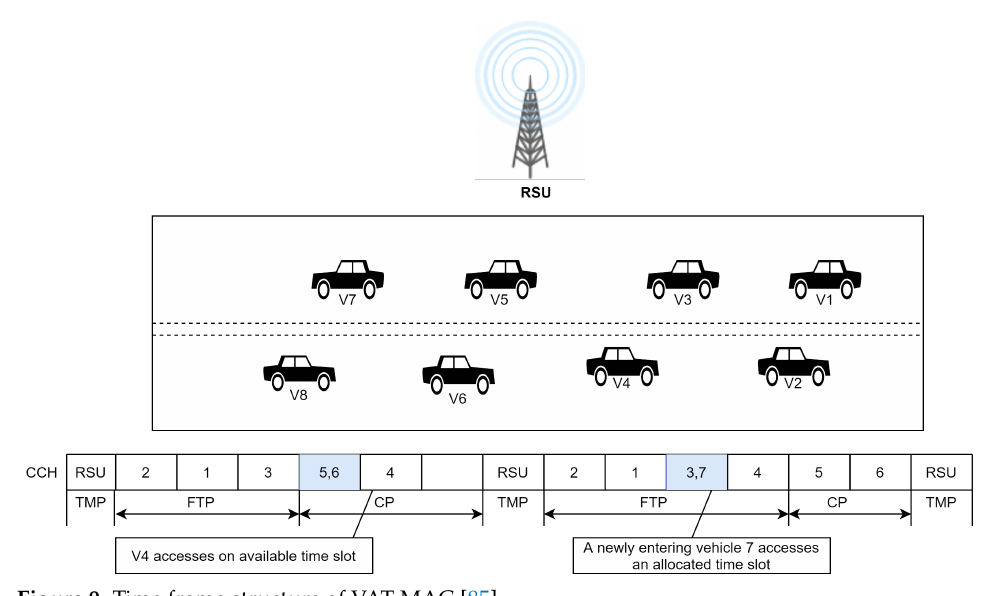
Figure 9. Time frame structure of VAT MAC